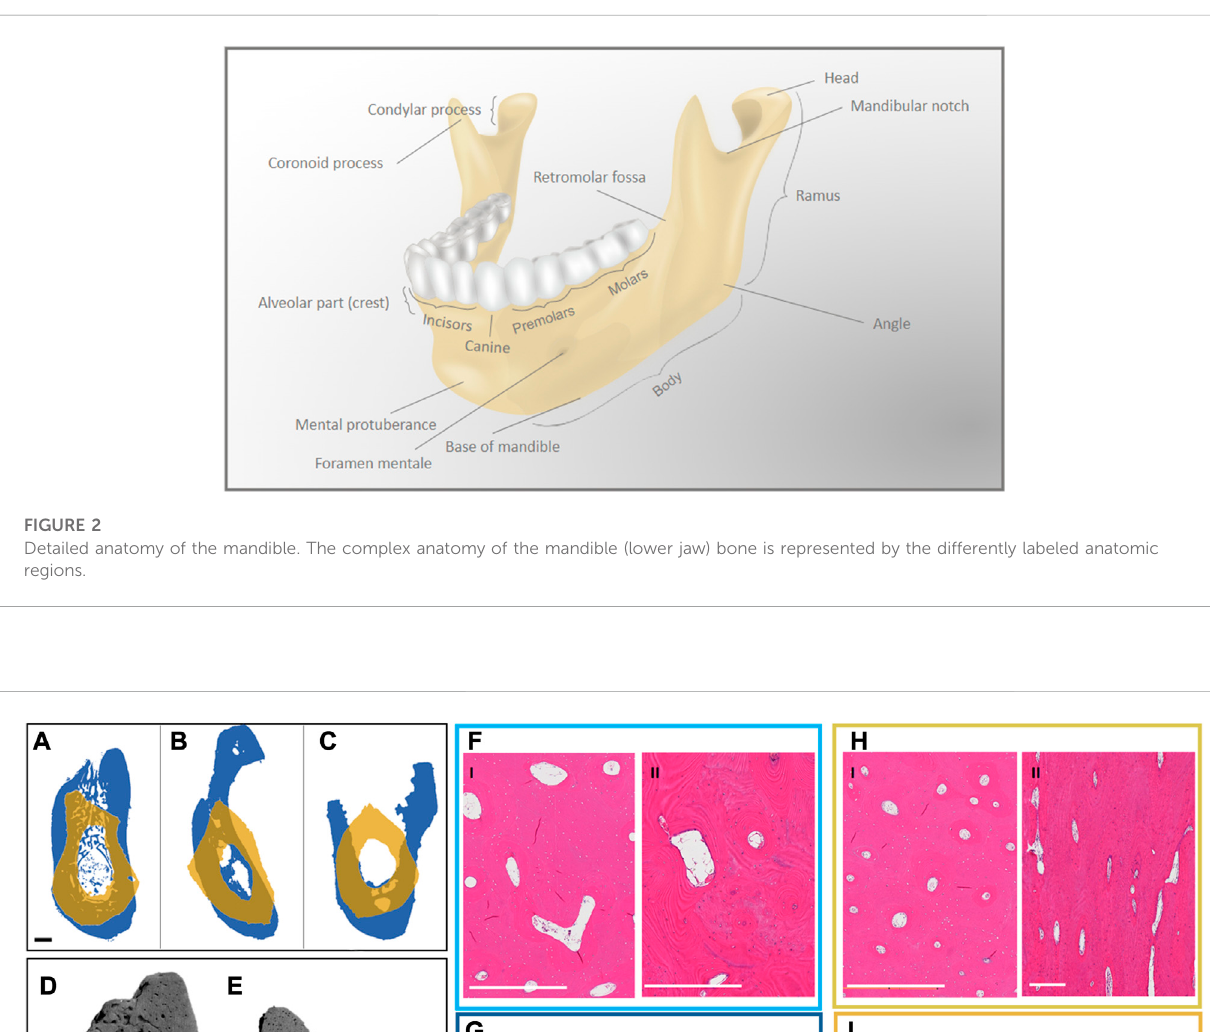
in the bone that house osteocytes and their minute dendritic extensions that form interconnecting channels (canaliculi), through which neighboring cells can communicate. The BMDD